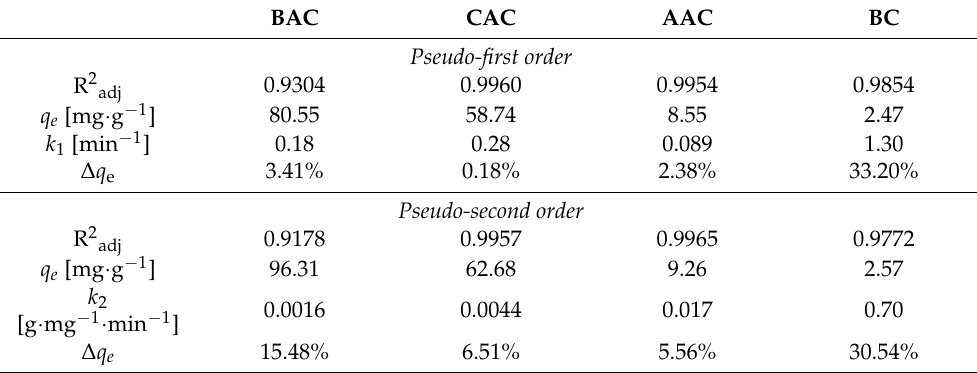
Table 4. Parameters of the kinetic models used in this study and respective determination coefficients for the four